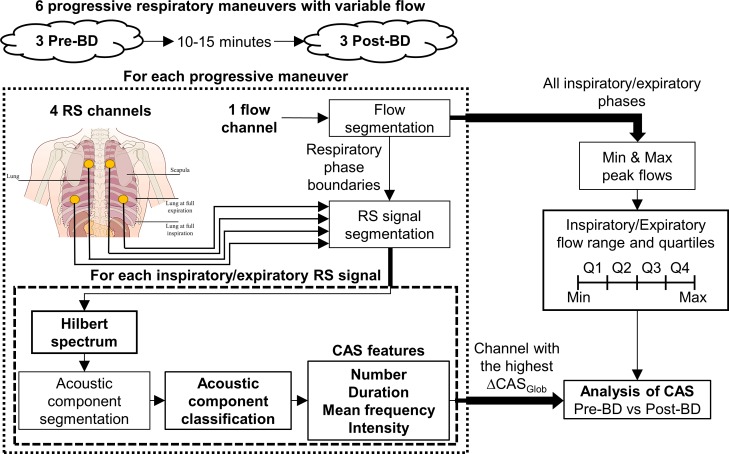
Flow chart of the proposed respiratory sound recording and CAS analysis approach.BD, bronchodilator; CAS, continuous adventitious sounds; Q1-Q4, flow quartiles; RS, respiratory sounds; ΔCASGlob, change in the number of CAS after bronchodilation.